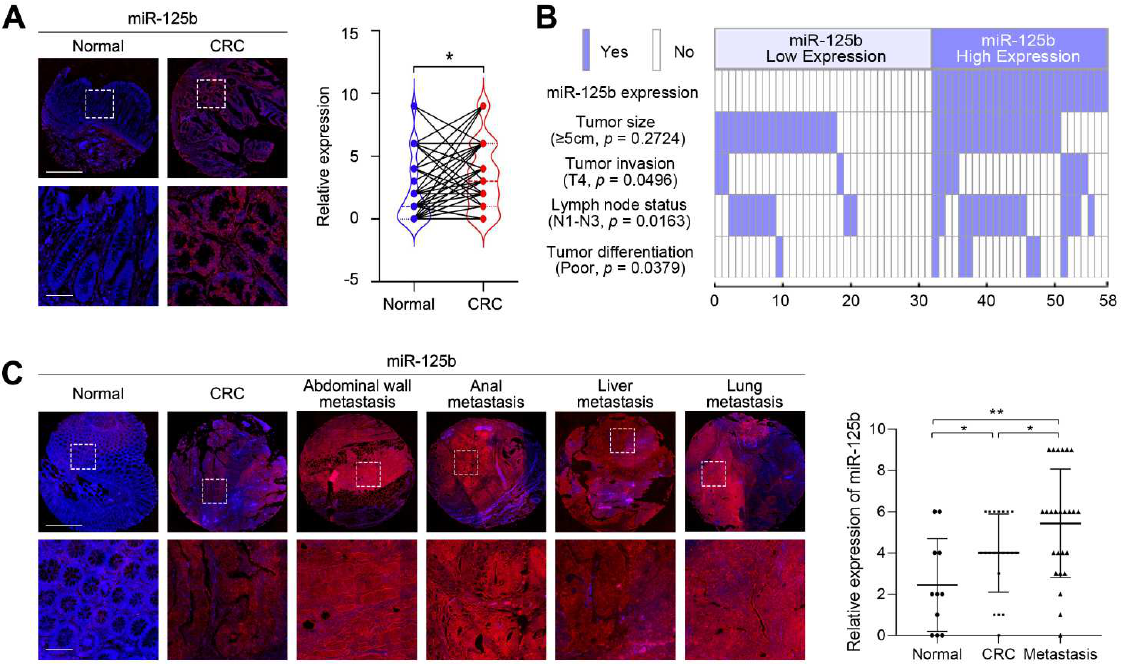
Figure 1. miR-125b expression is upregulated in metastatic colorectal cancer (CRC) tissues. ( A ) Representative images and analysis of fluorescence in situ hybridization (FISH) staining for miR-125b in 58 cases of CRC tissues and their matched adjacent normal tissues. p = 0.0130 ( n = 58; Normal vs. CRC). Magnified views of the regions indicated by the boxed area are shown below. Scale bars represent 200 µ m (upper) and 100 µ m (lower). ( B ) miR-125b expression positively correlated with tumor invasion, lymph node metastasis and tumor differentiation. ( C ) Representative images and analysis of miR-125b expression in normal colon tissues, primary CRC tissues and metastatic tissues detected by FISH. p = 0.0489 (Normal vs. CRC); p = 0.0423 (CRC vs. Metastasis); p = 0.0025 (Normal vs. Metastasis); n (Normal) = 11; n (CRC) = 21; n (Metastasis) = 25. Scale bars represent 500 µ m (upper) and 100 µ m (lower). * p < 0.05, ** p < 0.01 by Student’s t